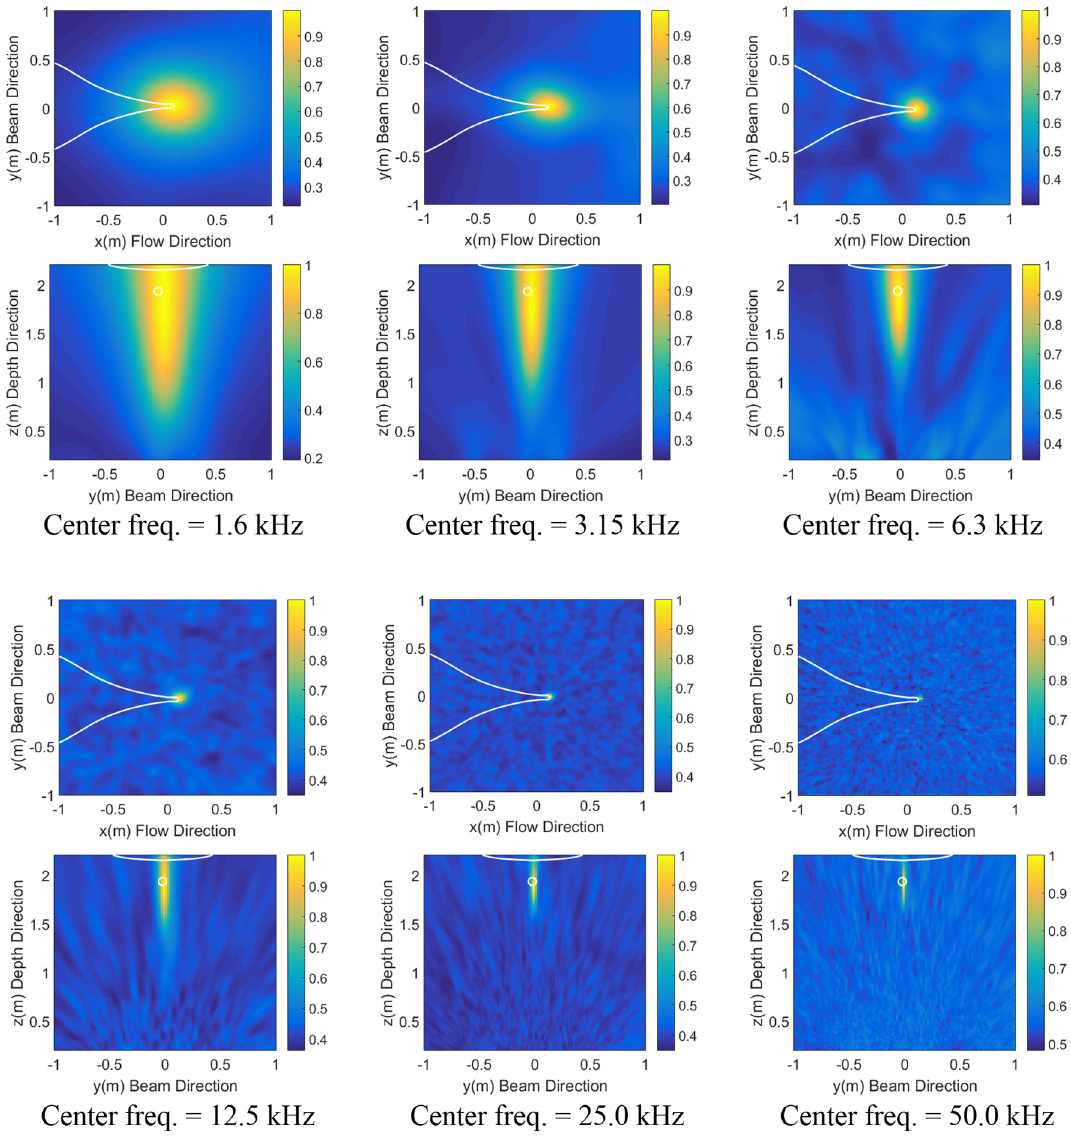
Figure 9. Ambiguity surfaces of the MV processor with direct arrivals using the 1/3 octave bands of which the center frequencies are shown in the plots. The reference position of the plane cut is ˆ r s = (0.1 m, ´ 0.02 m, 1.93 m). The outline of the model ship, which is cut correspondingly to each plane, is shown with the white line.